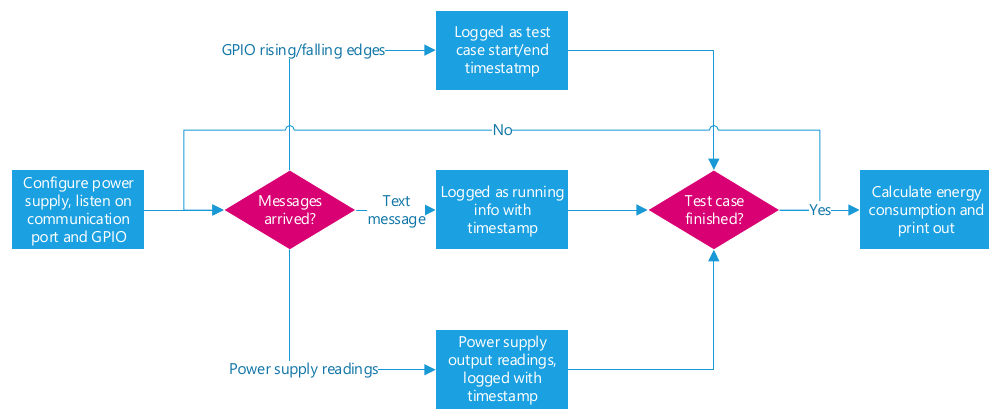
Figure 3. The workflow of the energy consumption measurement.